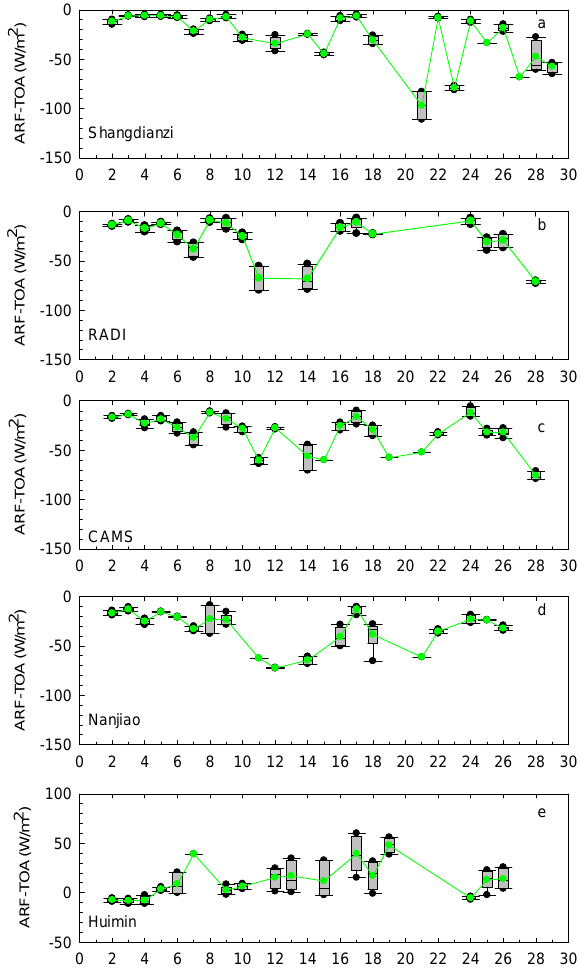
Fig. 10. Aerosol radiative forcing at the top of the atmosphere (ARF-TOA) and its 5th and 95th percentile box plots during Jan- uary 2013 at five sites in North China